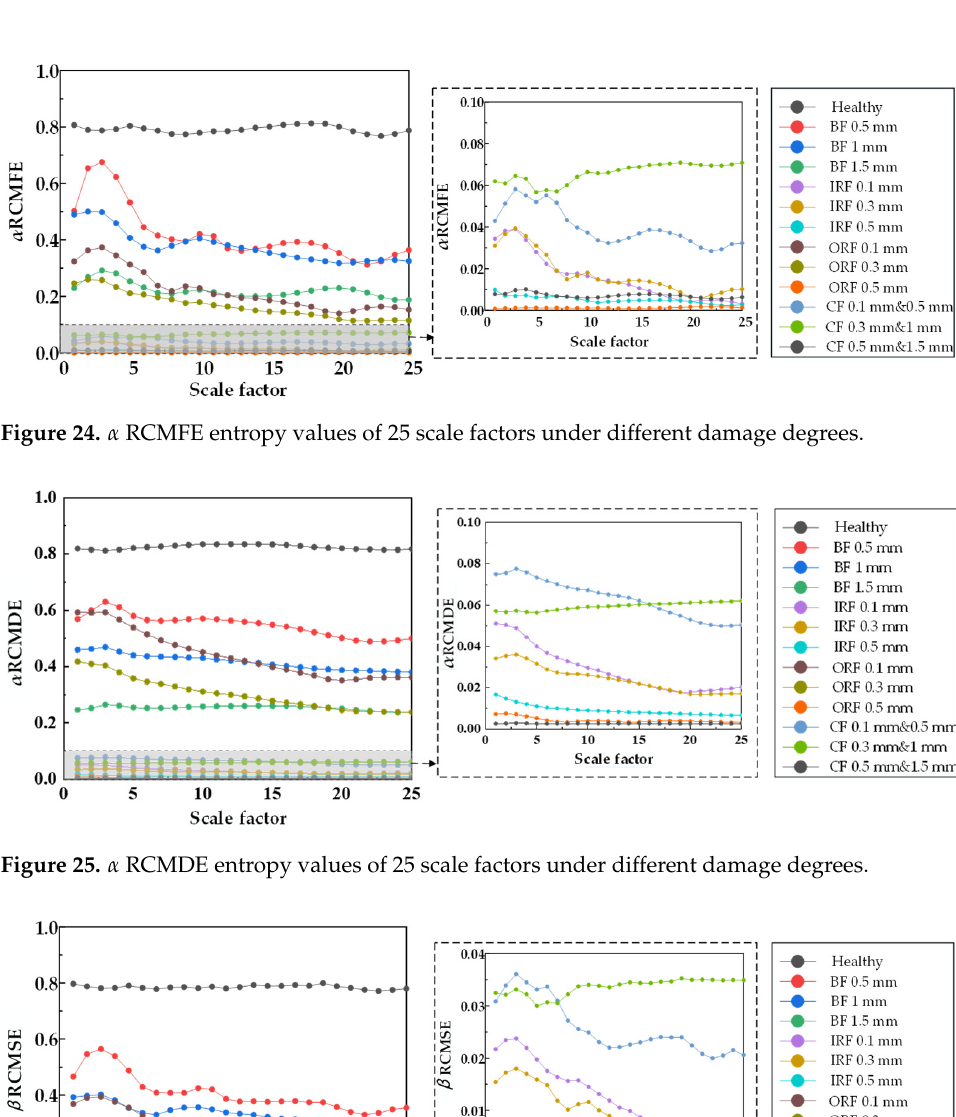
Figure 23. α RCMSE entropy values of 25 scale factors under different damage degrees.